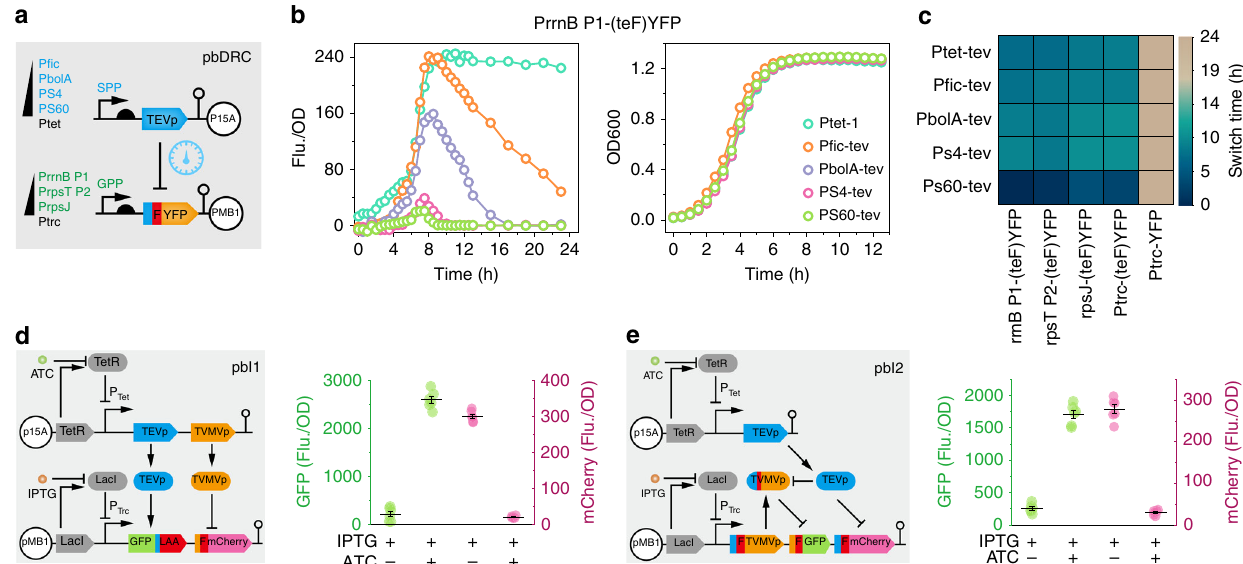
Fig. 2 Design and characterization of pbDRC and pbI. a The pbDRC design. The time difference in the initiation of gene transcription by different physiological-dependent promoters provide prescribed switch time in controlling protein abundance. b The fl uorescence abundance curve of strains with promoter rrnB P1-driven degradable YFP and SPP-driven TEVp. Ptet-1 represents a control plasmid without expression of TEVp. Cell growth curve of different pbDRC combinations (right). c Switch time in different promoter combination strains. Ptet-tev represents constitutively expressed TEVp. Ptrc- (teF)YFP and Ptrc-YFP represents constitutively expressed YFP with or without degradation signal. d First approach for pbI design. Two orthogonal proteases were co-expressed on a trigger plasmid. In the report plasmid, a TEVp recognition site was inserted between GFP and degradation tag LAA, and a TVMVp recognition site was inserted ahead of mCherry and a phenylalanine degron (F degradation signal). After expression of proteases, the degradable GFP became stable, whereas the stable mCherry became unstable. e Second approach for pbI design. TEVp was expressed on a trigger plasmid; TEVp- repressed TVMVp, TVMVp-repressed GFP, and TEVp-repressed mCherry were co-expressed on a report plasmid. After the TEVp expression, the mean ± SE. Source data of Fig. 2b – e are provided in Source Data fi